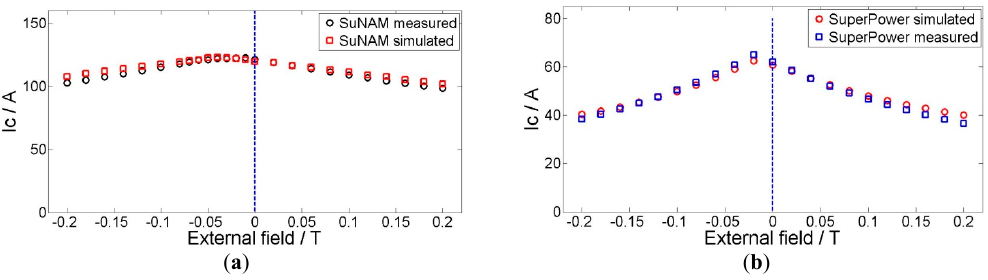
Figure 8. Comparison between measured and simulated critical current for SuNAM ( a ) and SuperPower ( b ) coil with 20 turns in different external fields. The measured critical currents are defined by 0.5 μ V/cm in E-I curves.